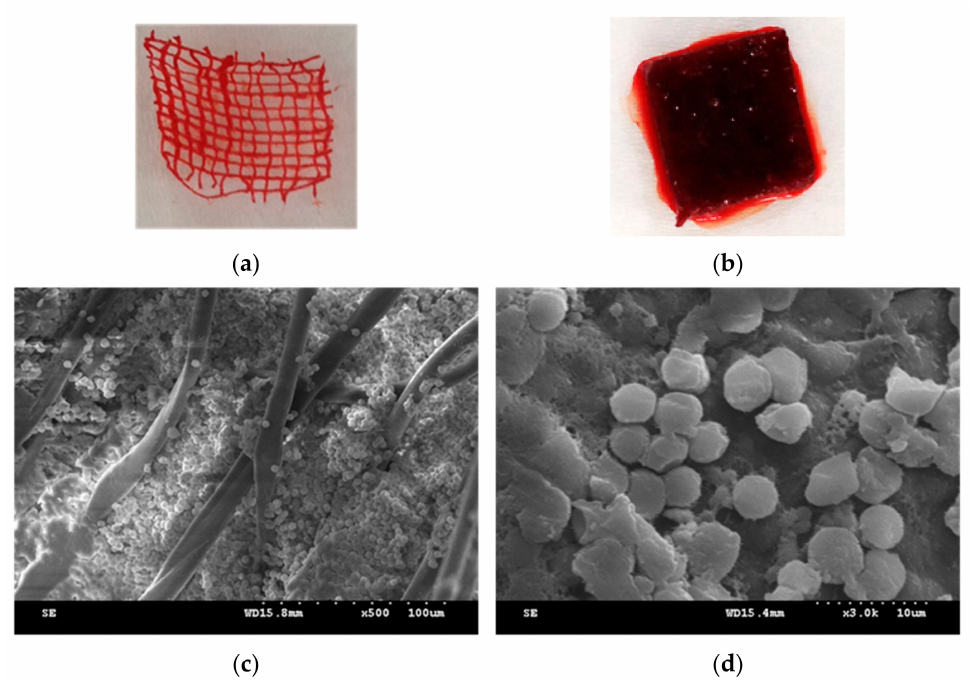
Figure 12. Blood absorption SEM images of ( a ) cotton fabrics and ( b ) 50PT nonwoven composites; ( c , d ) show 500 × and 3000 × magnification of 50PT nonwoven composites.